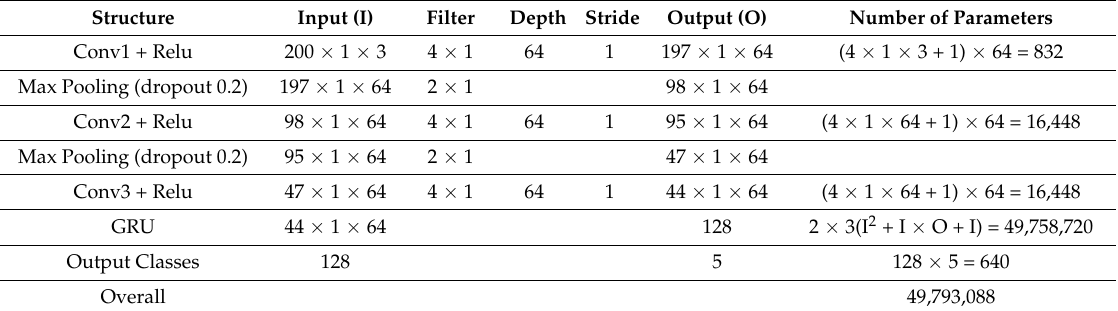
Table 1. Simplified Hybrid Single-Scale CNN–Gated Recurrent Unit (GRU) Model Structure and